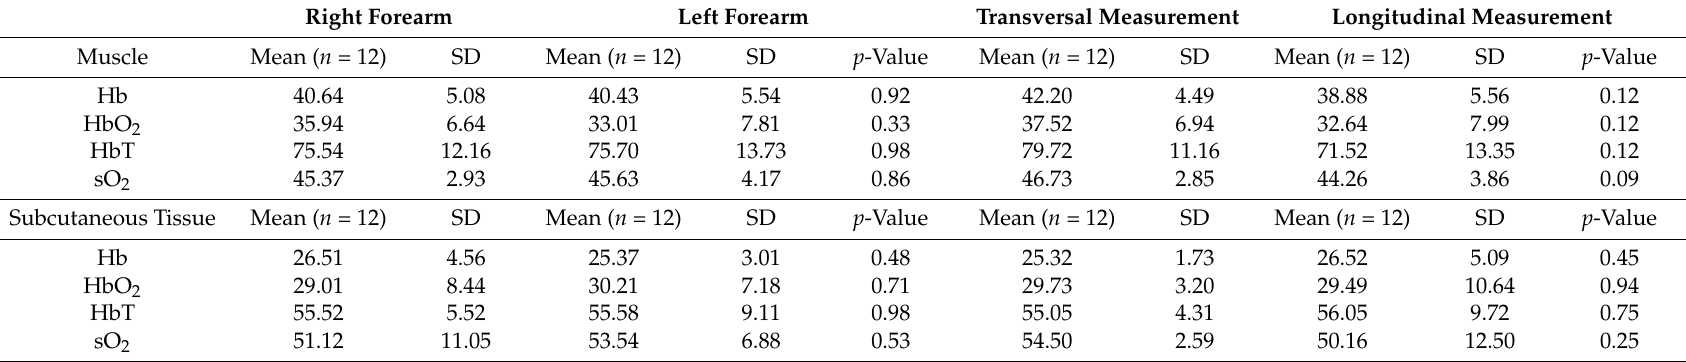
Table 1. MSOT mean values (a.u.) for muscular and subcutaneous tissue comparing both forearms as well as transversal and longitudinal probe orientation. Right Forearm